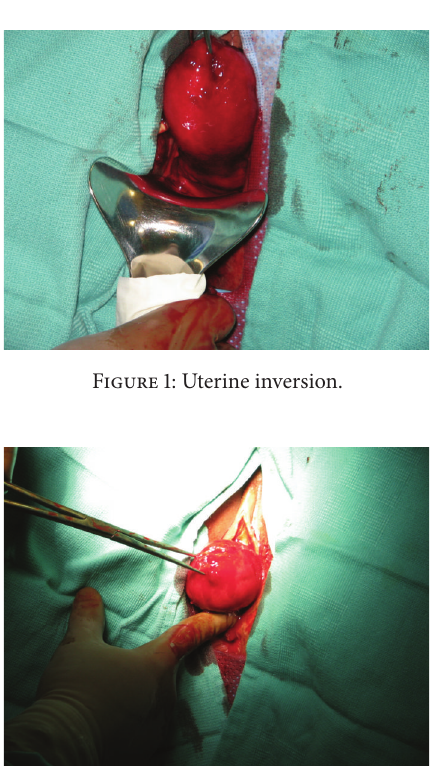
Figure 2: Uterine